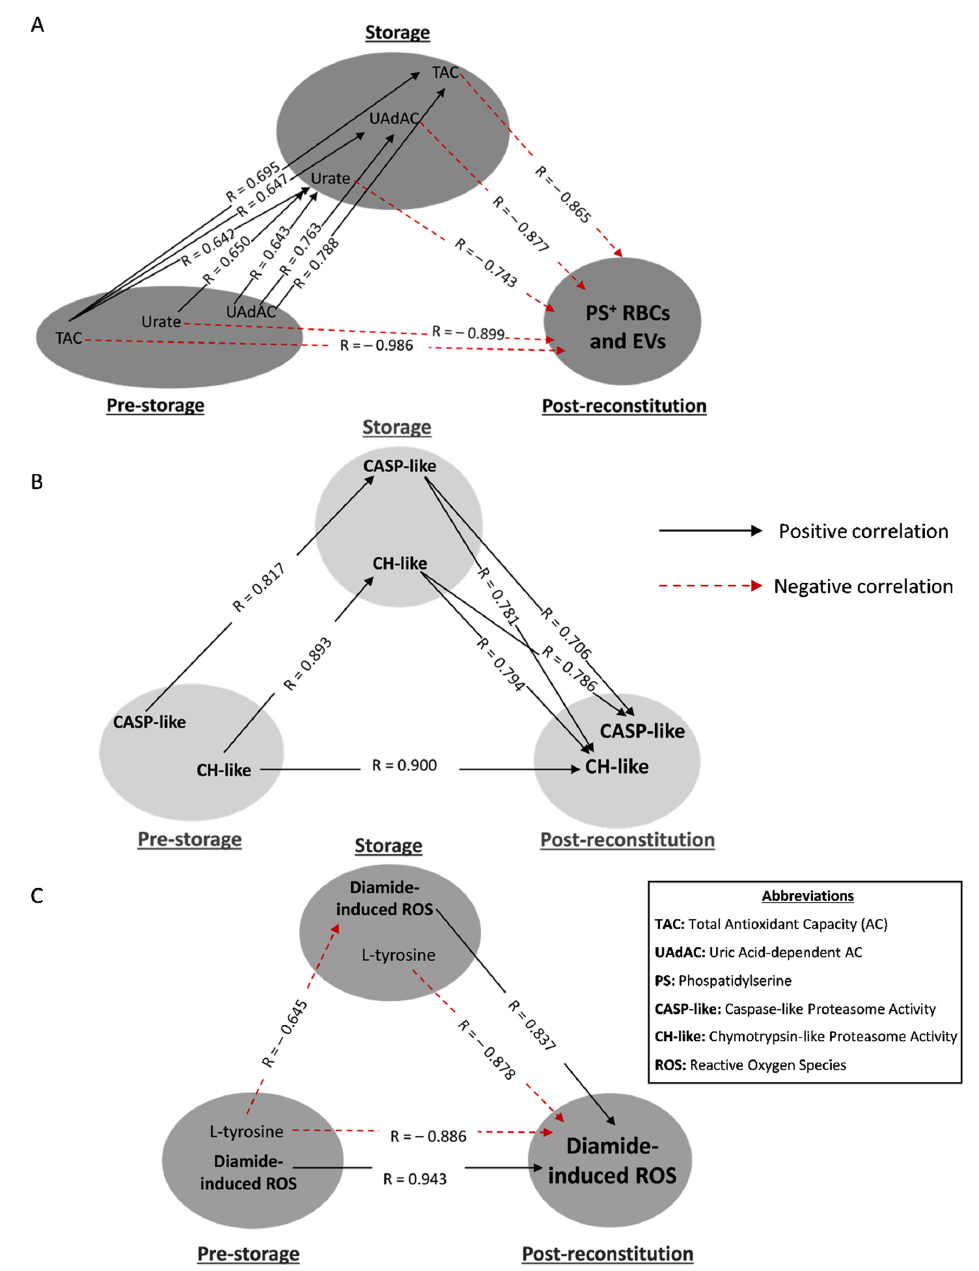
Figure 4. Statistically significant redox-related correlations between freshly drawn blood, stored, and reconstituted RBCs from beta-thalassemia trait ( β Thal + ) donors. The correlation triangles focus on ( A ) PS-exposing RBCs and extracellular vesicles (EVs), ( B ) proteasome activity and ( C ) diamide- induced intracellular ROS of reconstituted samples. All connections represent repeatable (at every recipient plasma and storage time-point measured) significant correlations. The R-values concern late storage and thalassemic plasma. Antioxidant capacities of ( A ) are extracellular, while urate is the intracellular metabolite.